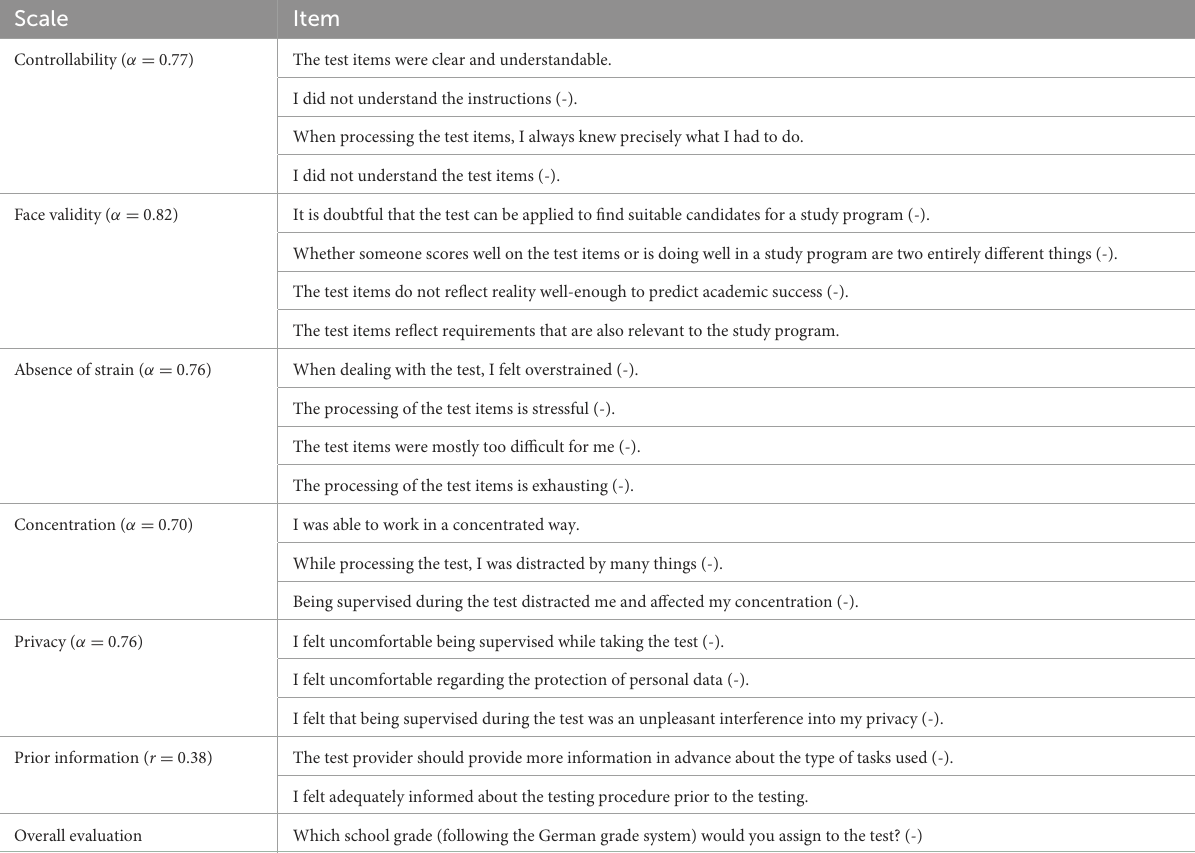
TABLE 2 Scales and items of the questionnaire and internal consistencies of the scales. Scale